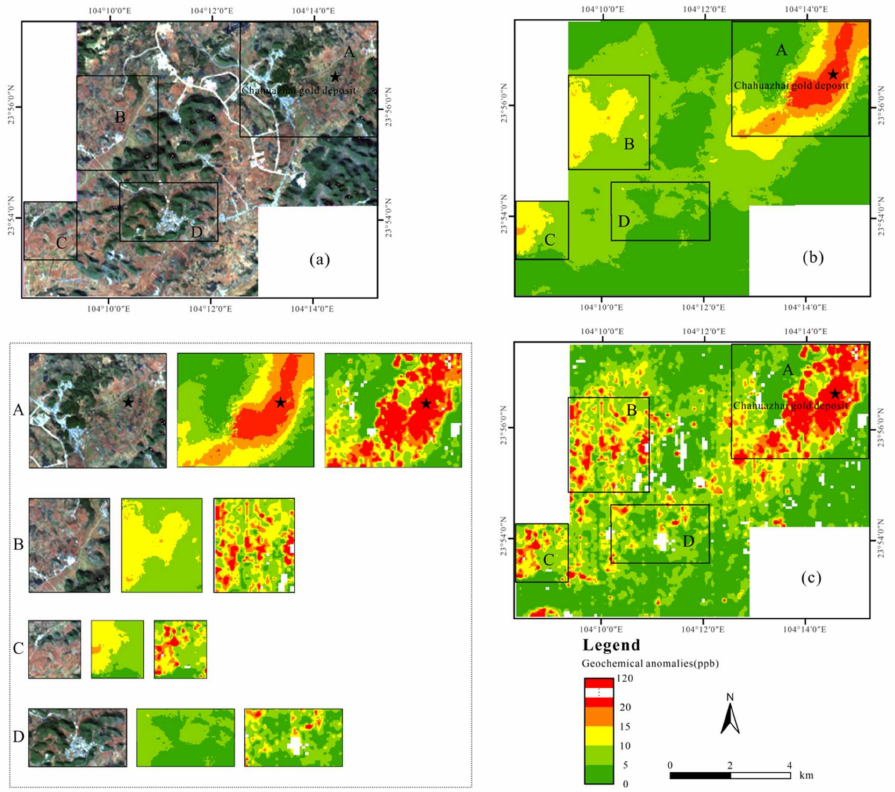
Figure 18. Zones of interest. ( a ) Original GF-5 hyperspectral image; ( b ) GWR prediction results; ( c ) geochemical exploration